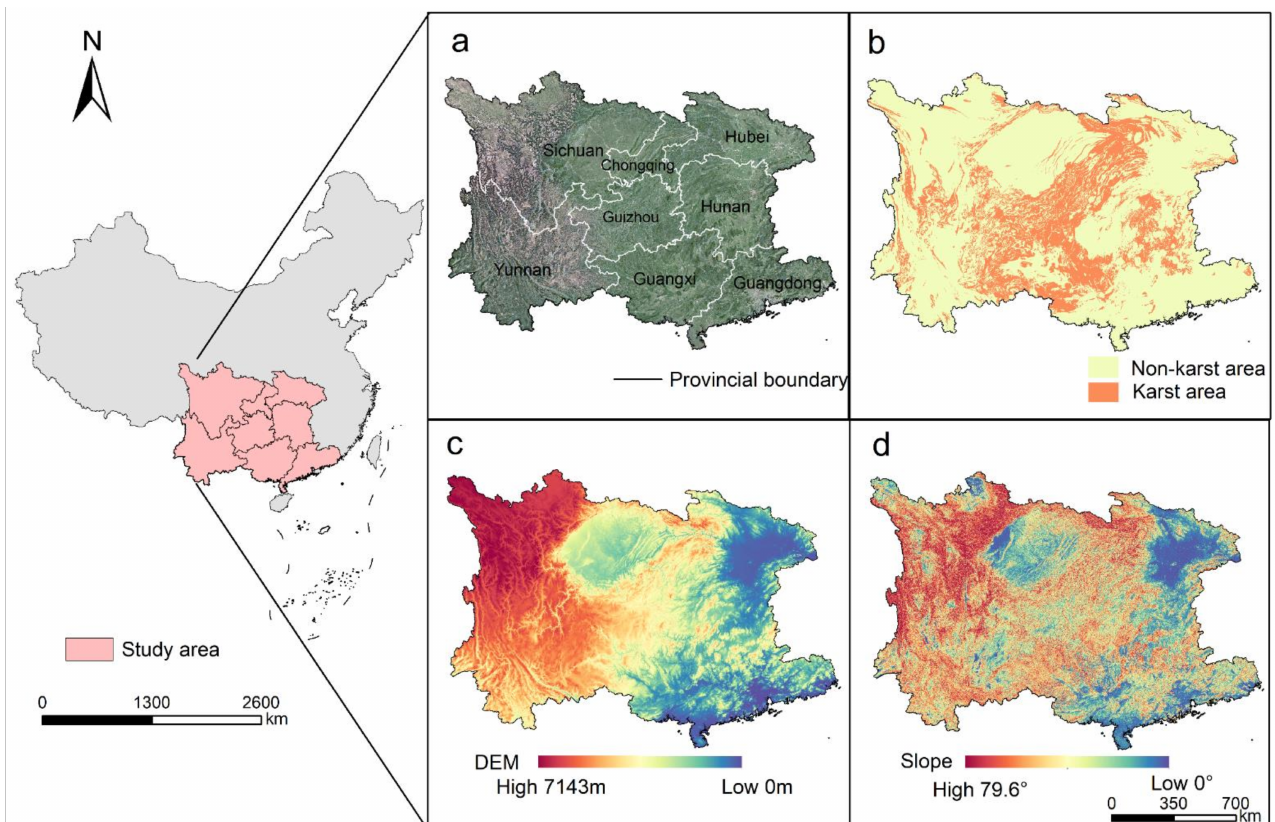
Figure 1. The location of the study area in China. ( a ) Provincial boundaries and Google Earth image of the study area; ( b ) distribution map of karst and non-karst areas; ( c ) elevation; ( d ) terrain slope distribution within the study area.